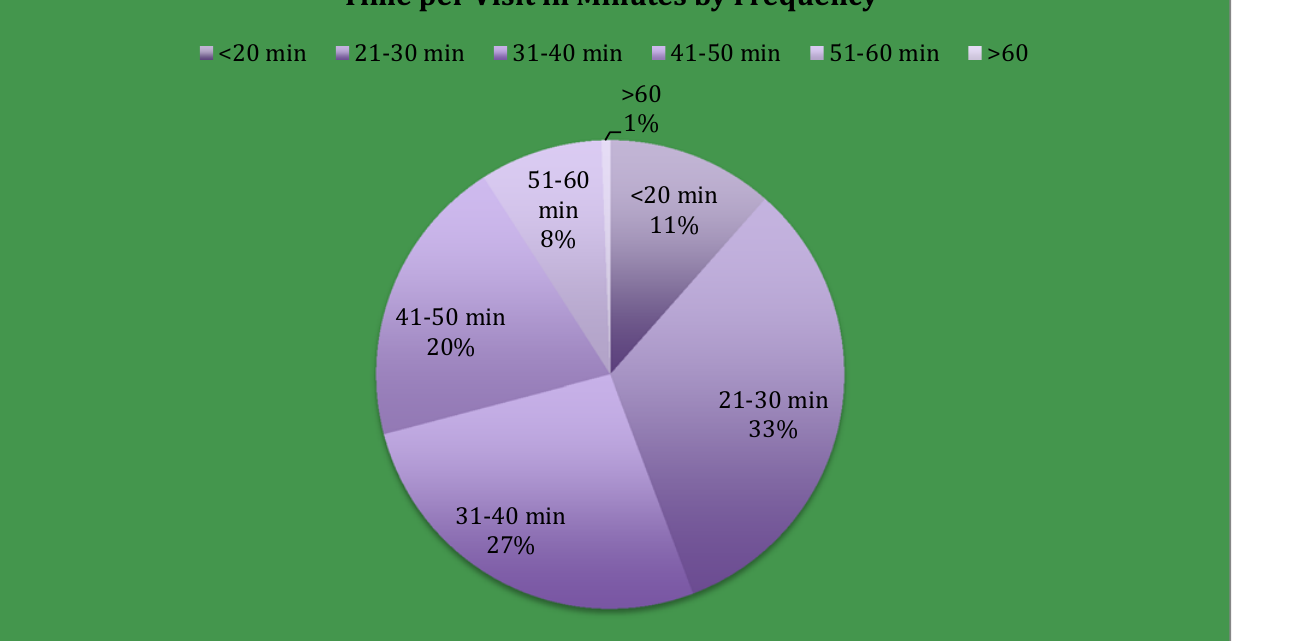
Figure 1. Time per Visit in Minutes by